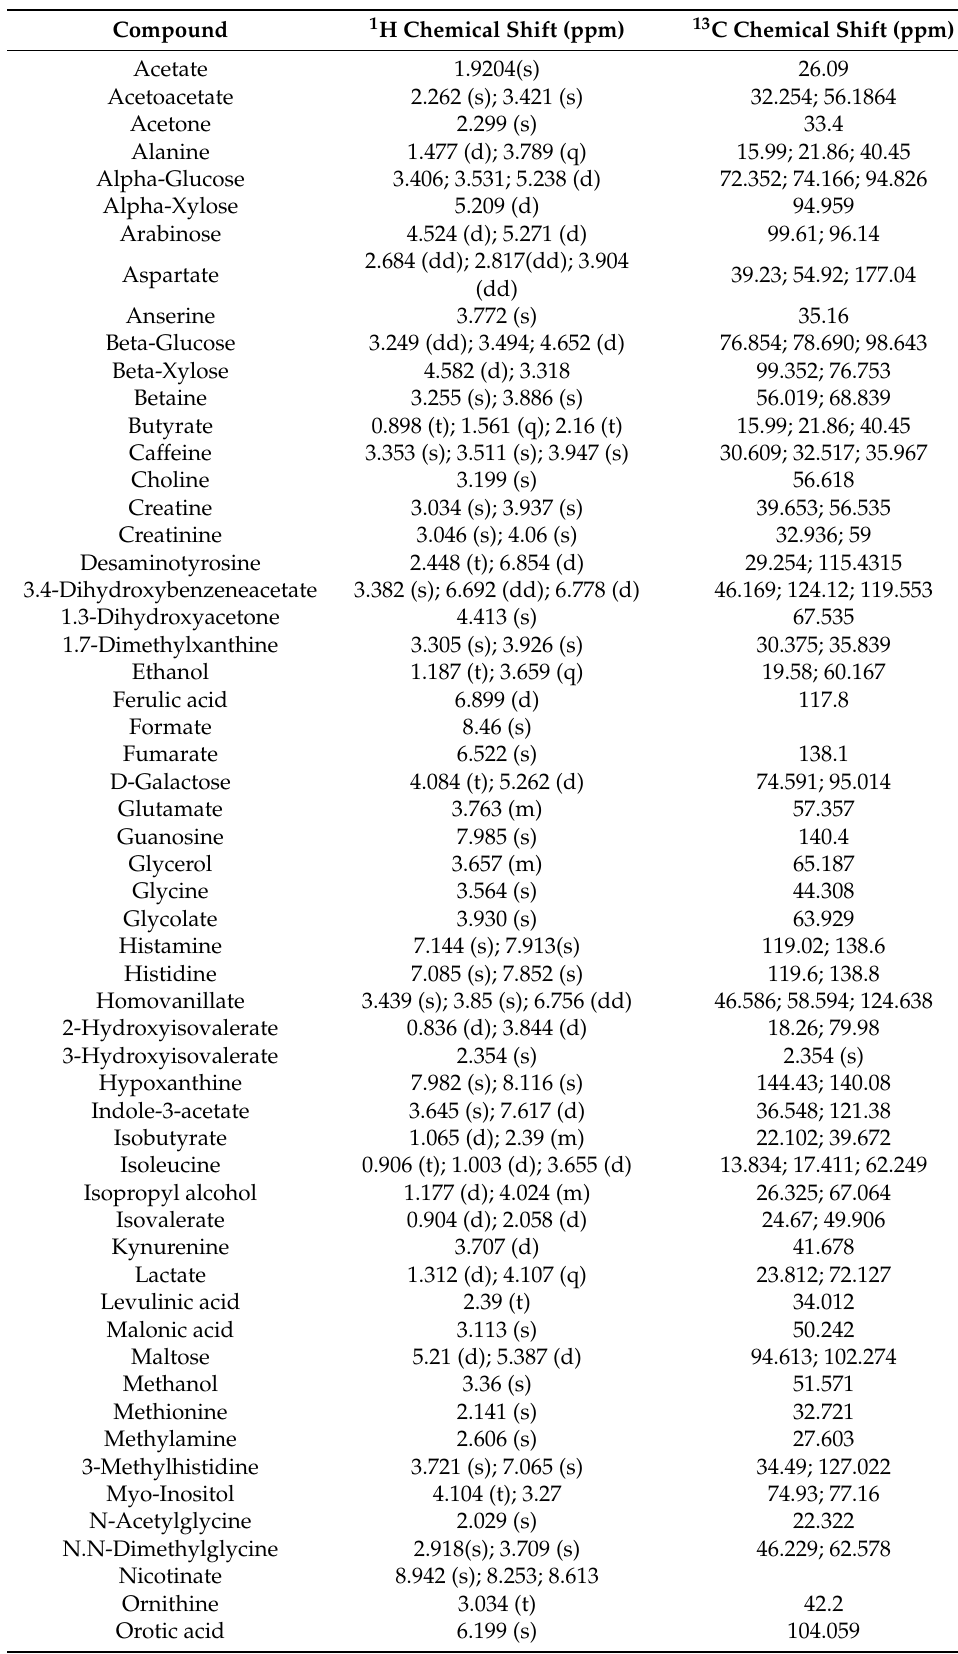
Table 2. Assignments of detected metabolites 1 H and 13 C